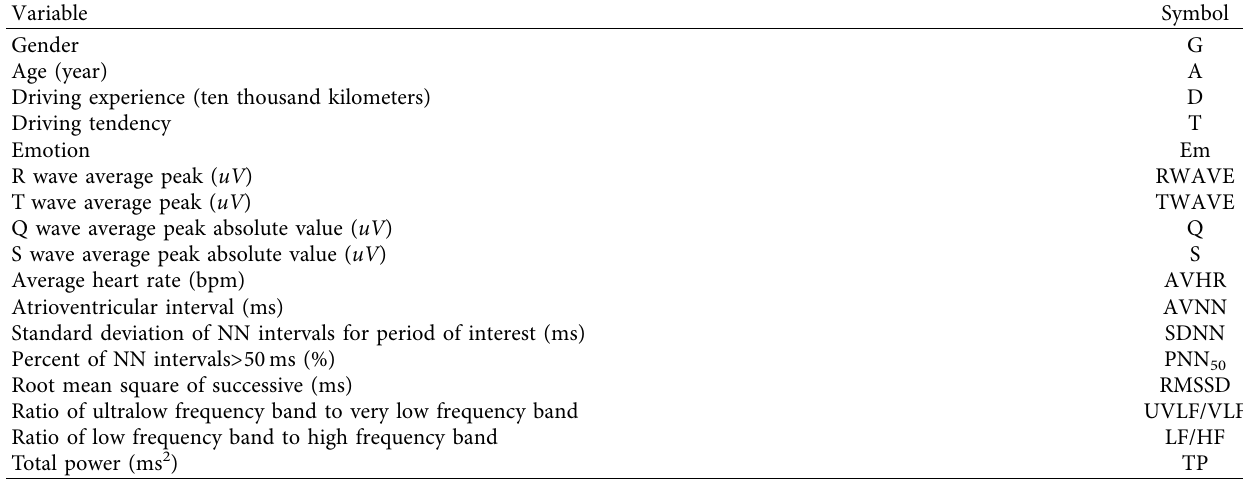
Table 4: Variables and symbols in the experiment.